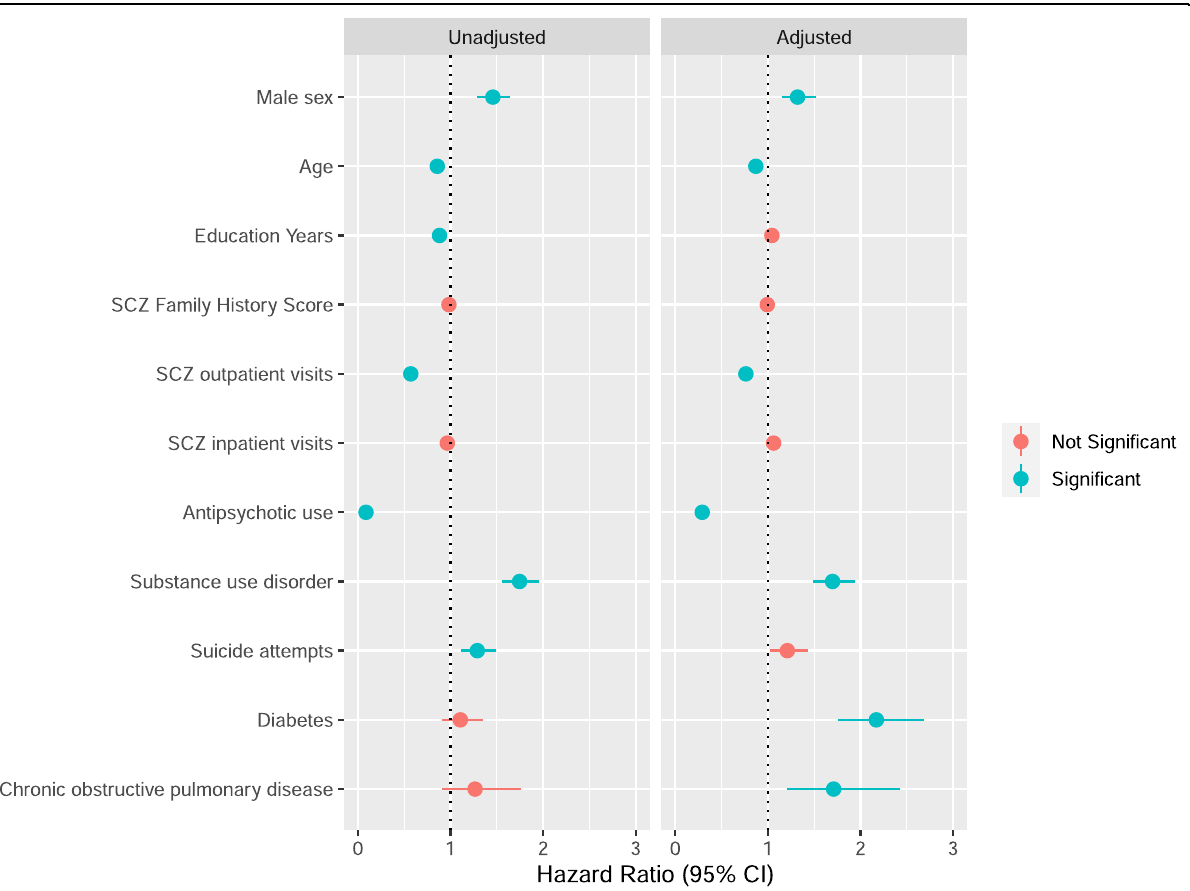
Fig. 1 Cox proportional hazards regression modelling of factors associated with mortality in a Swedish national population-based sample of schizophrenia (SCZ) cases. The unadjusted model considers each factor individually and the adjusted model includes all listed factors in one model. The adjusted model additionally contains major depressive disorder. Total N for all exposures in the unadjusted model: 13,727 SCZ cases (1268 died), except for education years (13,375 SCZ cases, 1112 died) and SCZ family history score (13,275 SCZ cases, 1179 died). Total N for the adjusted model: 12,973 SCZ cases (1064 died). The information in this fi gure is the same as what is represented in Supplementary Table 3. NS not signi fi